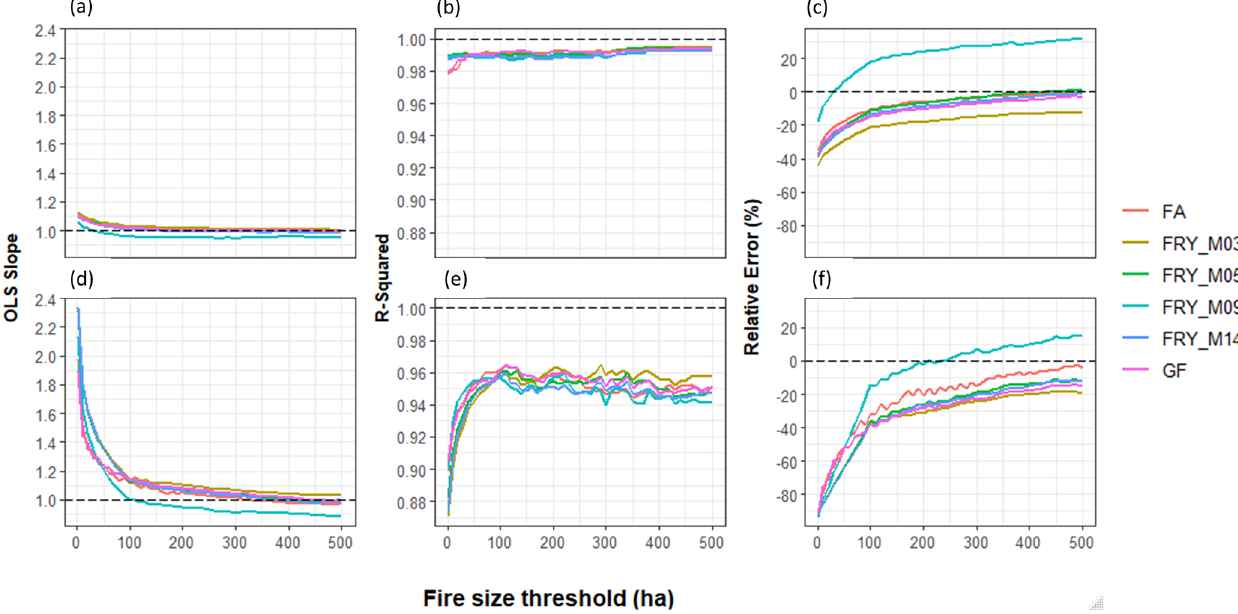
Figure A1. Evaluation of RSDs including all FRY cutoff values (3 to 14d) through different metrics including the slope (a, d) , R 2 correla- tion (b, e) , and relative error (c, f) for both burned area (a–c) and the number of fires (d–f) over a range of individual fire size thresholds (1 to 500ha). Dashed lines indicate a perfect fit between RSDs and the GBD.